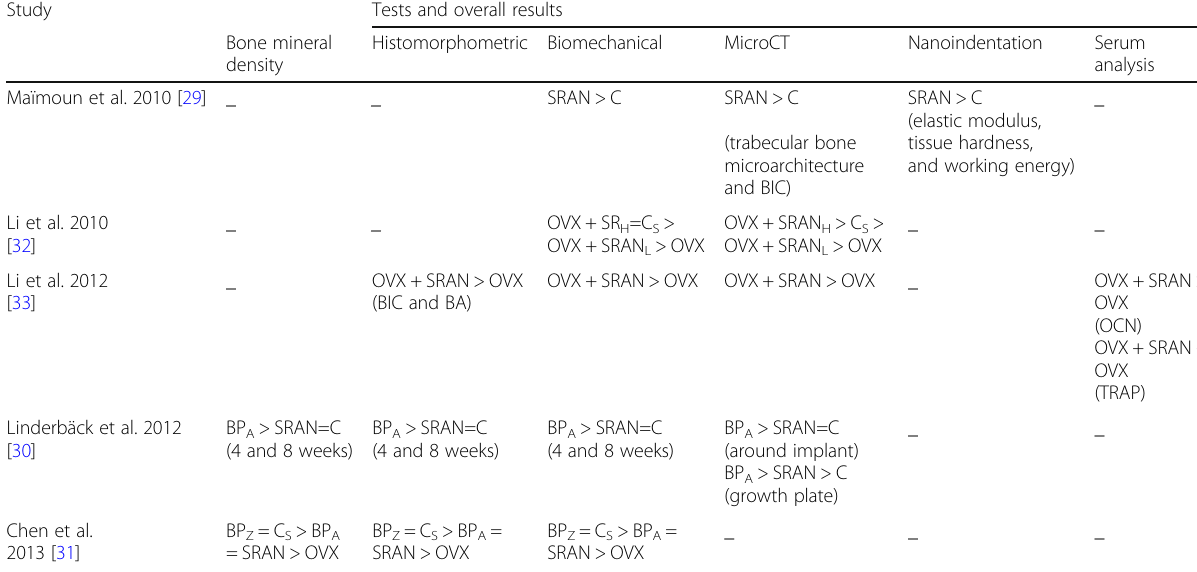
Table 2 Included studies and the evaluation methods employed, together with major outcomes for each method Study Tests and overall results Bone mineral